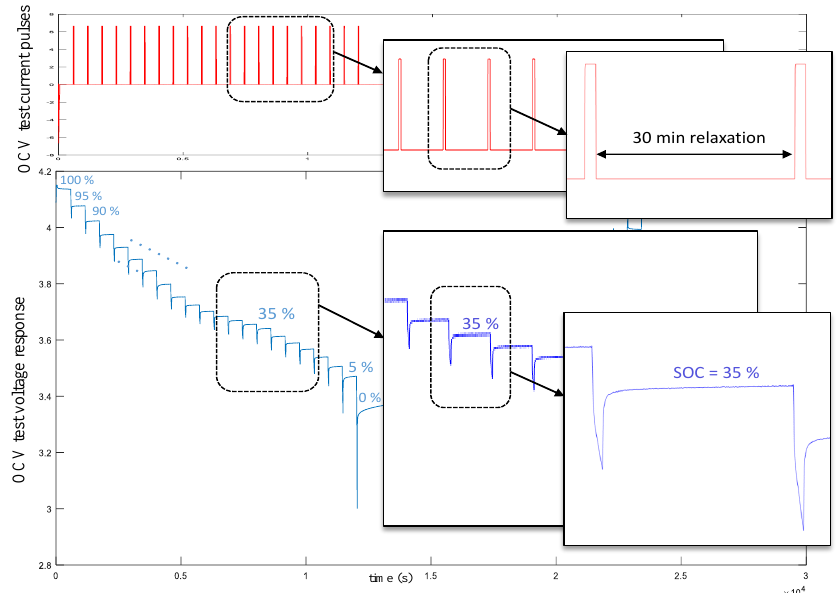
Figure 2. The OCV discharge test current and voltage response.